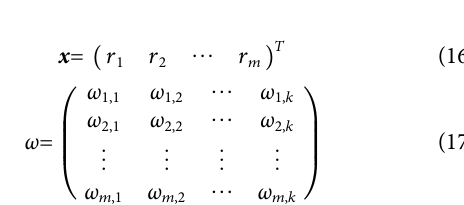
FIGURE 5 | The data from the master meter.